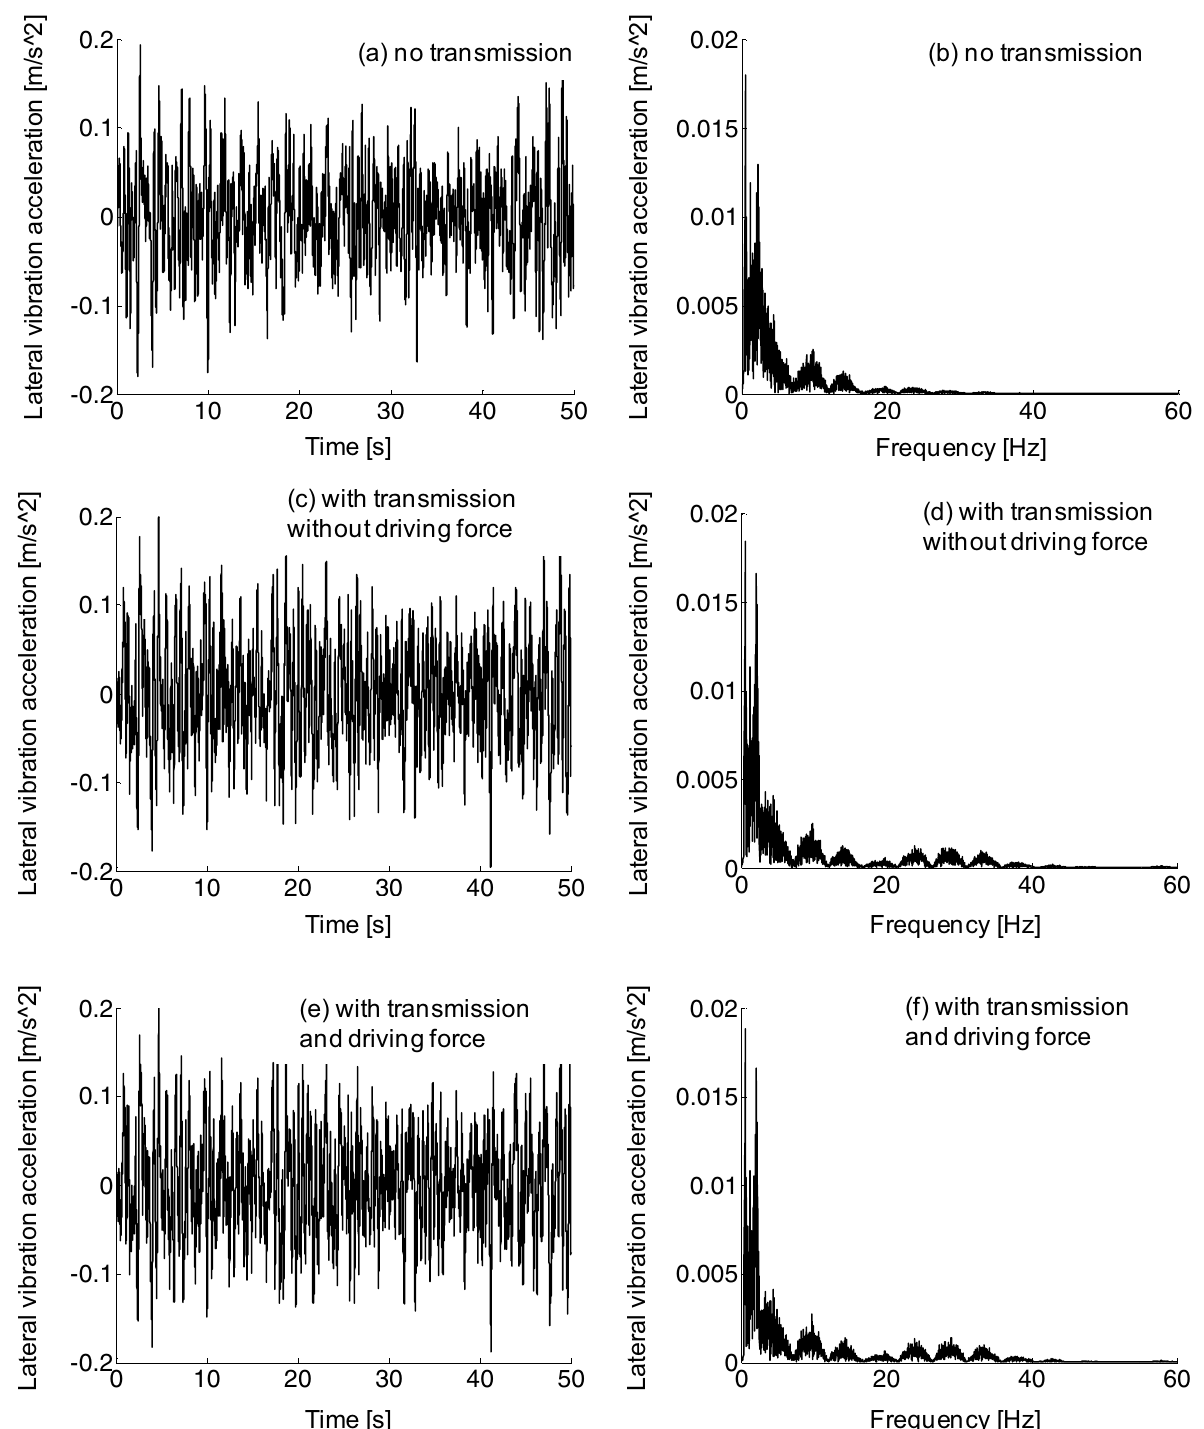
Figure 16. Car body lateral vibration acceleration, (a-b) no transmission, (c-d) with transmission without driving force, (e–f) with transmission and driving